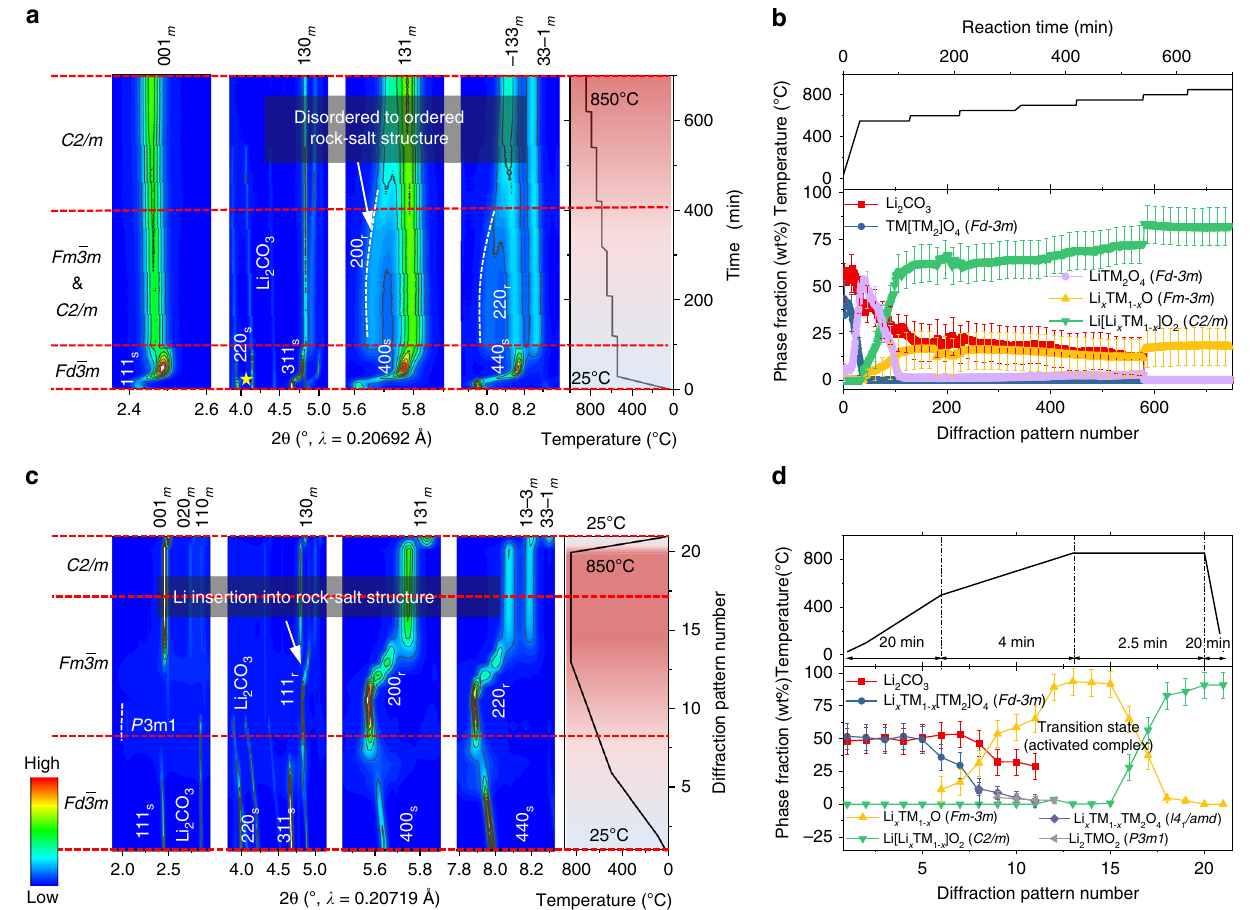
Fig. 4 The original formation mechanism of LMLOs and the anomalous lattice contraction behavior in the cubic Li-containing rock-salt-type phase. Contour plot of in situ HTSRD pattern of a mixture of L0.00 and Li 2 CO 3 under a slow-heating and c fast-heating process, respectively. On the right side of the SRD pattern is the corresponding calcination process. Each diffraction pattern was analyzed using the Rietveld re fi nement method, the resultant weight fraction of various phases showing the Li/O-incorporation-induced structural evolution during b slow and d fast-heating route between 25 and 850